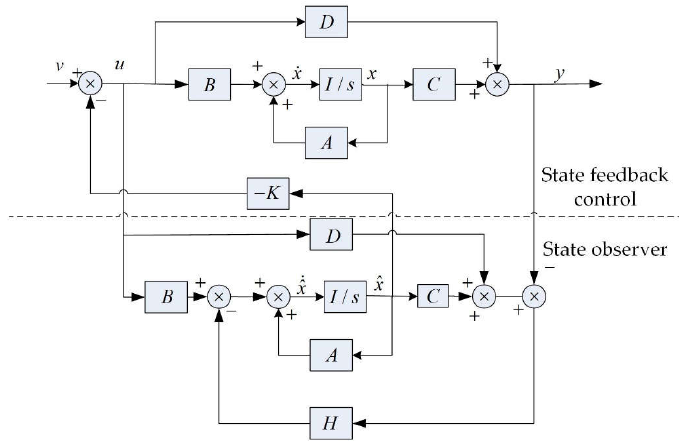
Figure 8. Diagram of state